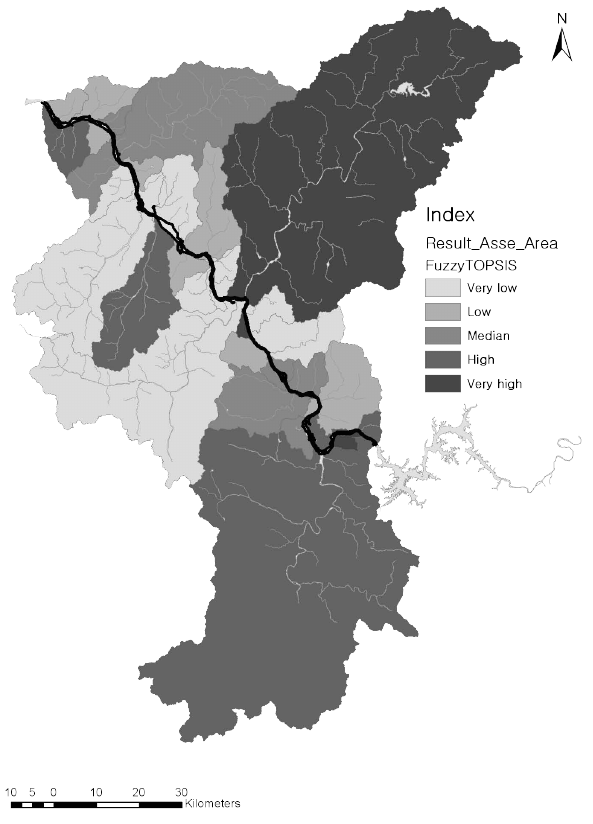
Fig. 13. Spatial flood vulnerability results for the South Han